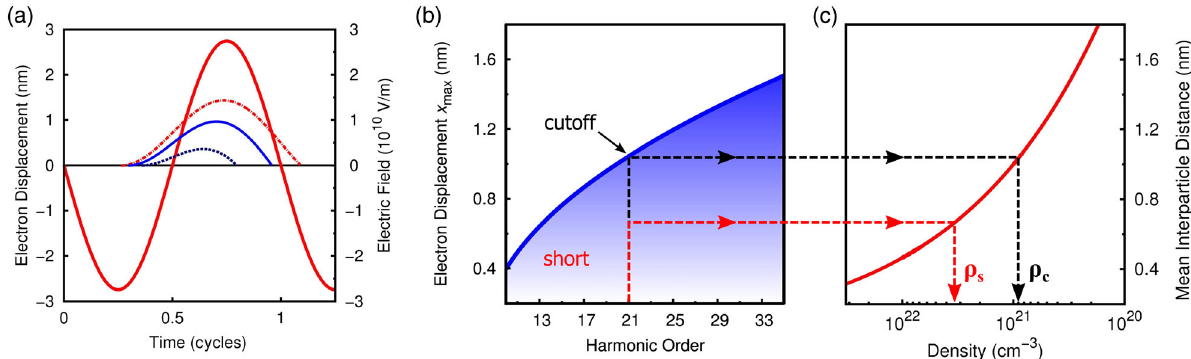
FIG. 1. Determination of the maximum tolerable target density for HHG. (a) Calculated electron trajectories during HHG. Depending on the time of ionization by the electric field (solid red line), different quantum paths contribute to the HHG process, such as the short (dotted blue line), the cutoff (solid blue line), and the long trajectory (dashed red line). Different trajectories may result in the same photon energy, but can be distinguished by the time spent within the continuum and by the maximum displacement of the electron x (b) Calculated range of maximum electron displacement as a function of harmonic order. The blue solid line indicates the displacement along the cutoff trajectory. As the driving intensity increases, the maximum excursion of the electron contributing to a fixed harmonic order decreases (color scale) since the harmonic shifts from the cutoff into the plateau region, and the process occurs via the short quantum path. (c) Mean interparticle distance versus target density (solid red line). Comparing (b) and (c) allows us to determine the maximum tolerable density of the target, upon which a perturbation of electronic trajectories sets in and the HHG process is suppressed. Depending on the trajectory, two values are obtained: ρ c (dashed black arrow exemplarily for the 21st order) for the cutoff, and a lower, intensity-dependent value for the short trajectory ρ s (dashed red